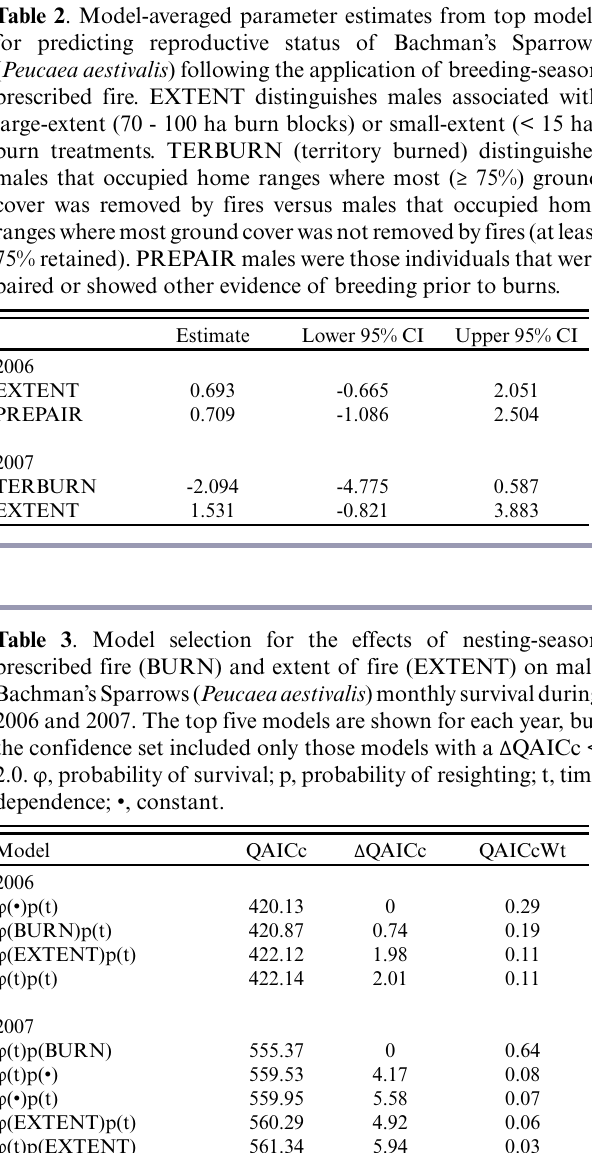
between burned and unburned treatments with burned plots having a lower resighting probability (0.51, SE = 0.05) than unburned plots (0.67, SE = 0.04).